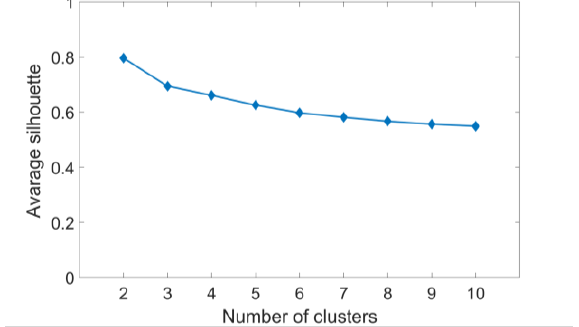
Figure 7. Average silhouette coefficients for a number of clusters ranging from 2 to